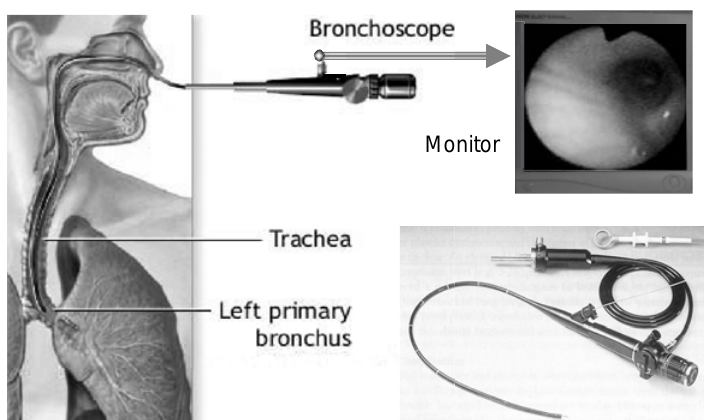
Fig. 1. Illustration of the method to visualize the airway opening/narrowing by °exible ¯ber optical nasopharyngoscopy. A °exible ¯ber optical nasopharyngoscope is shown in the lower right panel. The tip of the optical ¯ber, ¯tted with a CCD camera was inserted into the airway passage of the test subject through the nasal cavity, and carefully placed near the location of the airway as shown in the left panel. Subsequently, the cross section of the airway lumen was imaged by the CCD camera on the tip of the scope, and the digital image was viewed in real time on the monitor as shown in the upper right panel, as well as stored in the memory device of a computer (not